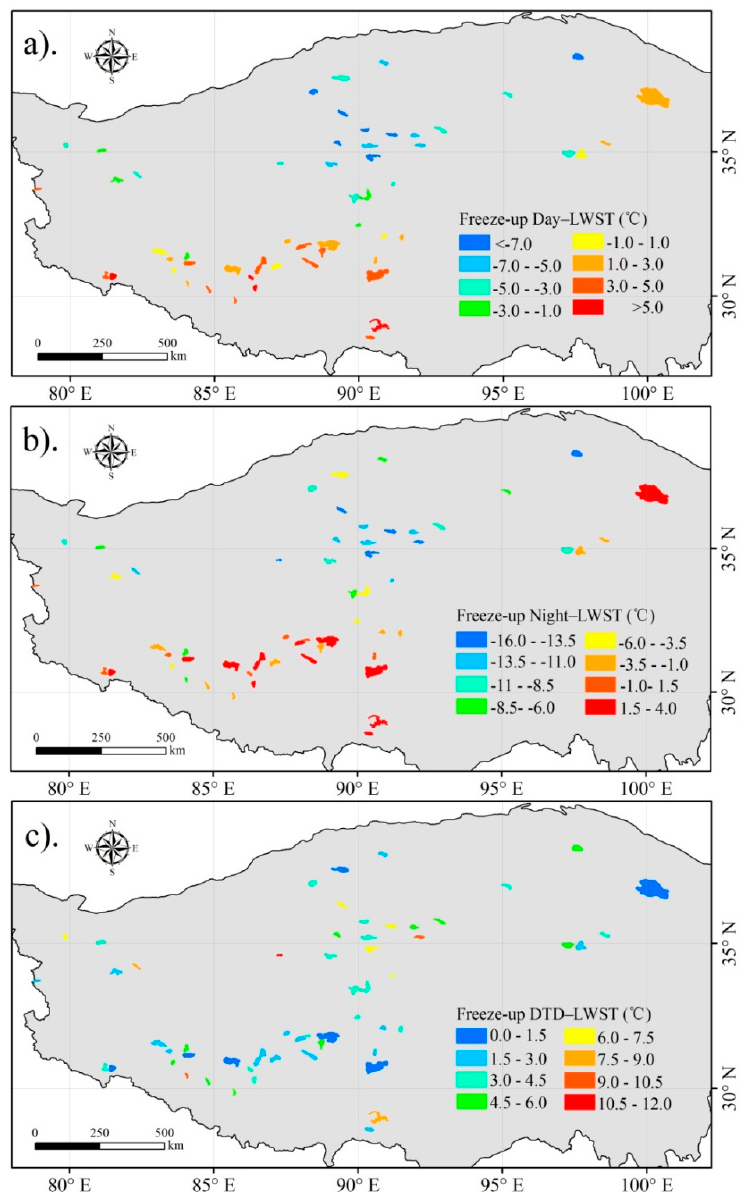
Figure 5. The spatial pattern of the monthly averaged water surface temperature before freeze-up period in Tibetan Plateau: ( a ) LWST daytime variation; ( b ) LWST nighttime variation; and ( c ) lake water surface diurnal temperature difference (DTD).